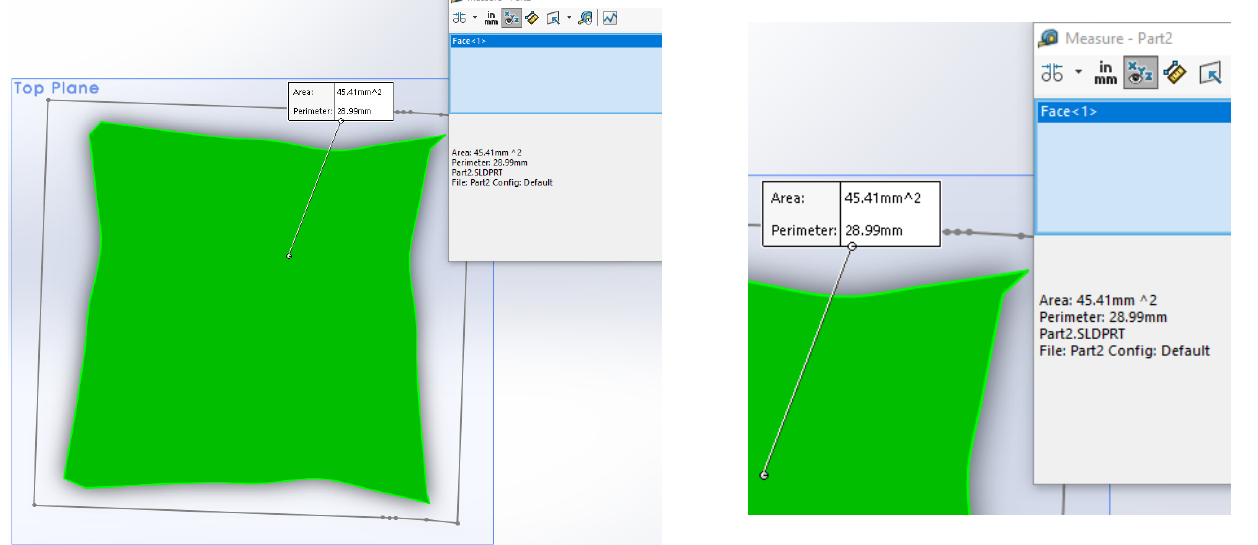
Figure 5. Initial (marked by line) and final (green) cross-section area of specimen P1-1.